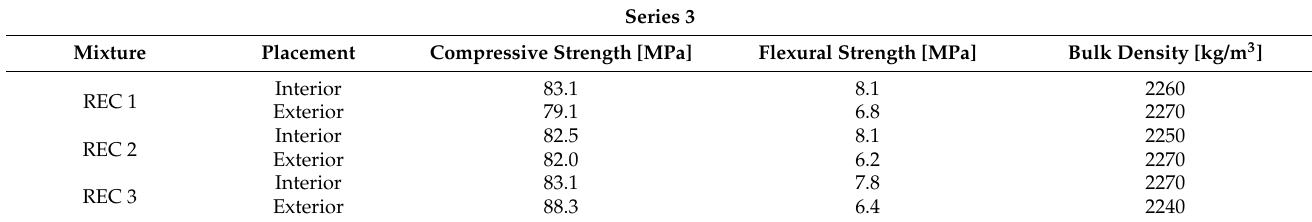
Table 7. Results of basic physical and mechanical properties for Series 3.